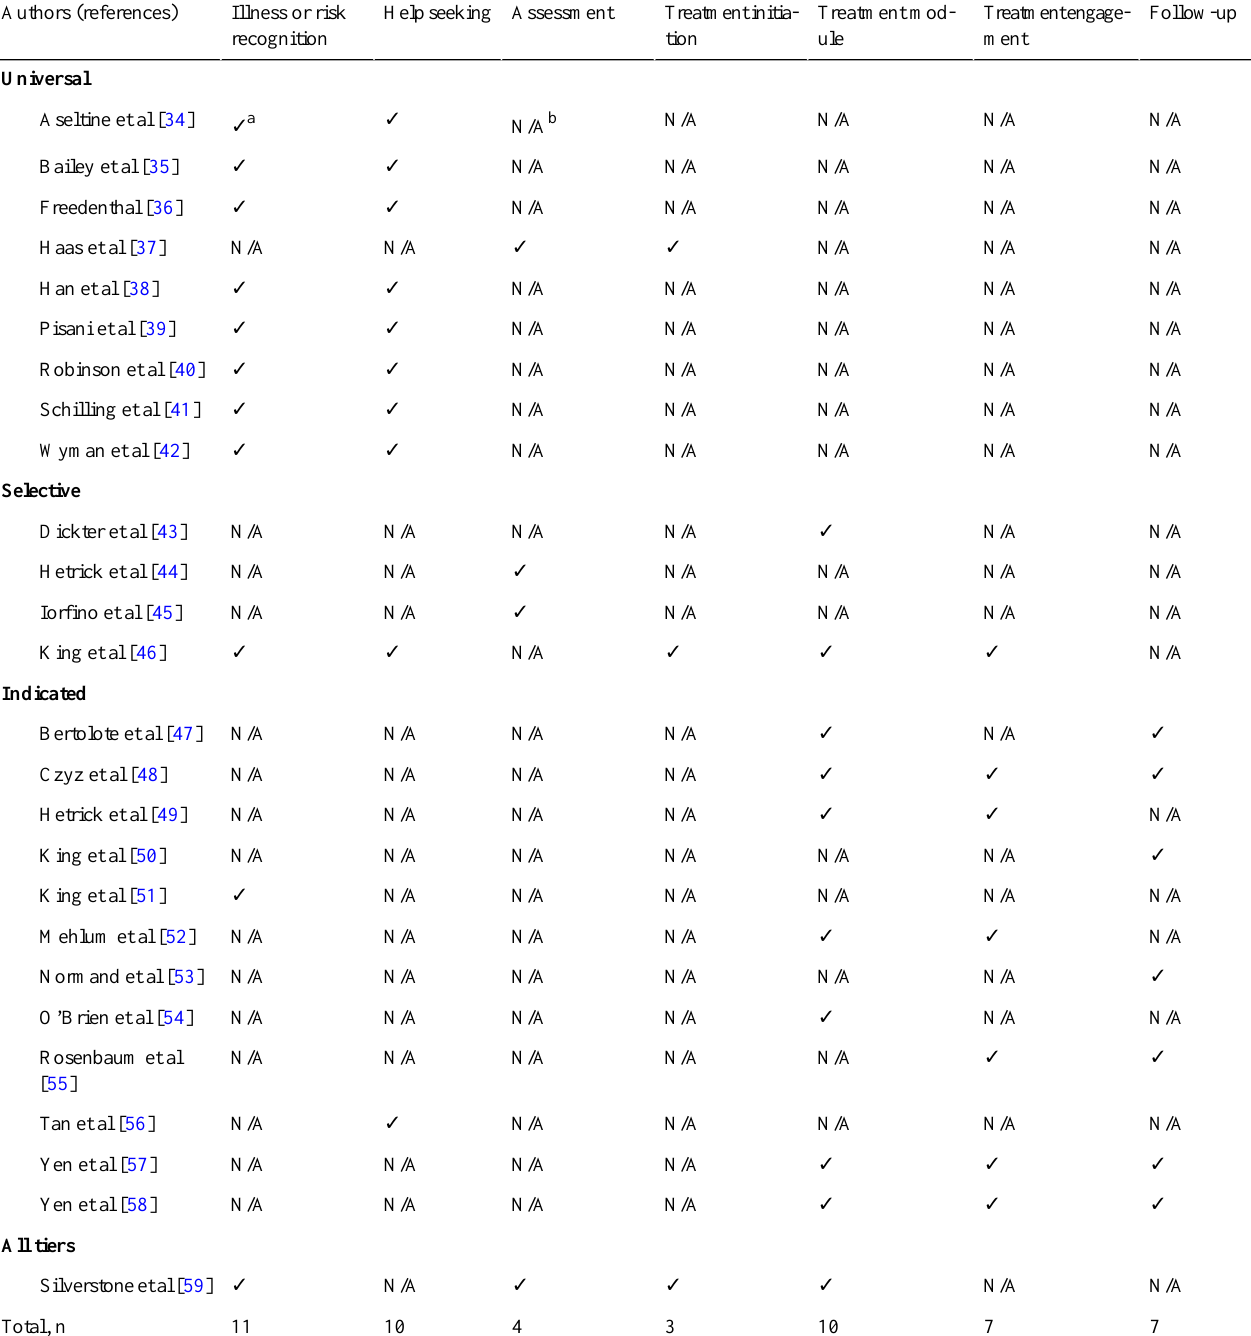
Table 3. Studies and their stages on the continuum of